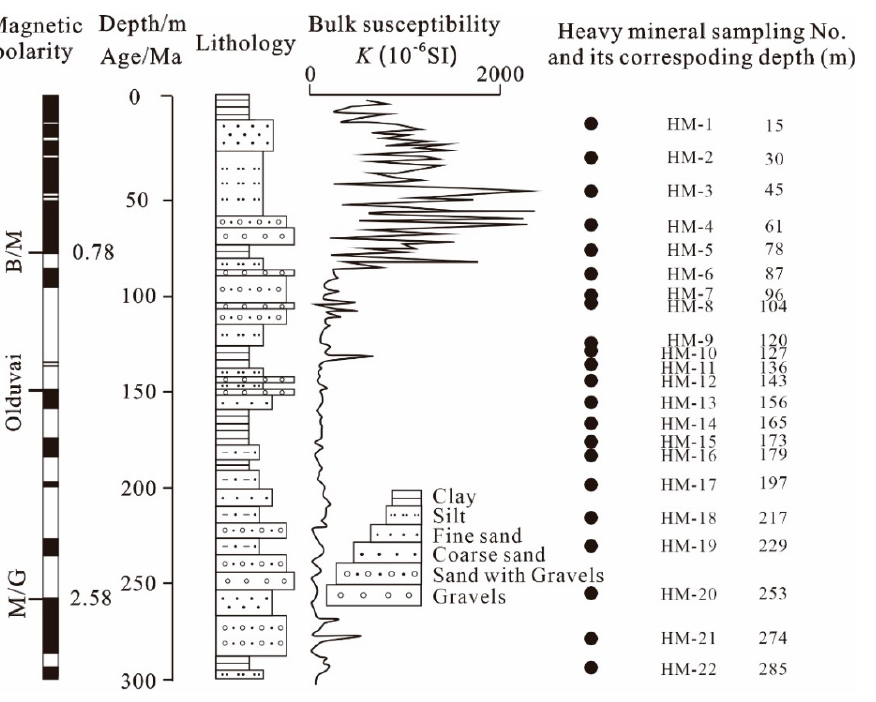
Figure 3. Magnetic polarity and lithology of late Cenozoic sediments in the Jianghan Basin (Zhoulao core), as well as heavy mineral sampling numbers and corresponding depths. HM: heavy mineral; B/M: Brunhes—Matuyama boundary; M/G: Matuyama—Gauss boundary; the black dot represents sampling